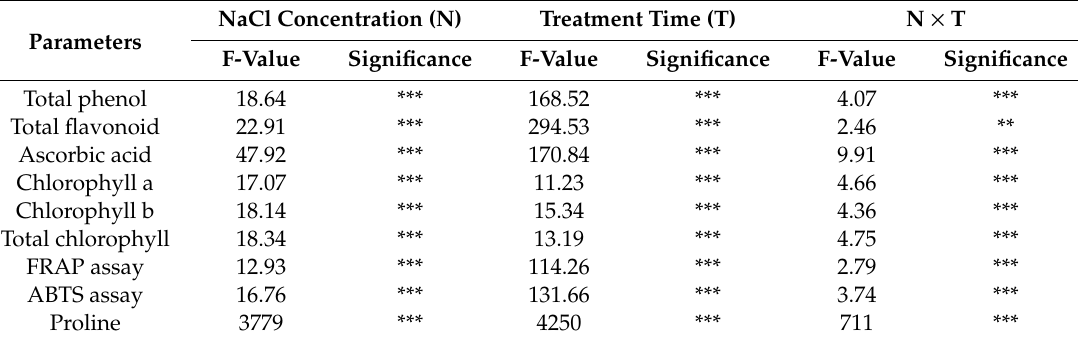
Table 4. Summary of analysis of variance for total phenol, total flavonoid, ascorbic acid, chlorophyll, proline, ferric reducing antioxidant power (FRAP) assay, and 2,2 (cid:48) -azino-bis(3-ethylbenzothiazoline -6-sulfonic acid) [ABTS] assay in the lettuce seedling at the NaCl concentrations and treatment